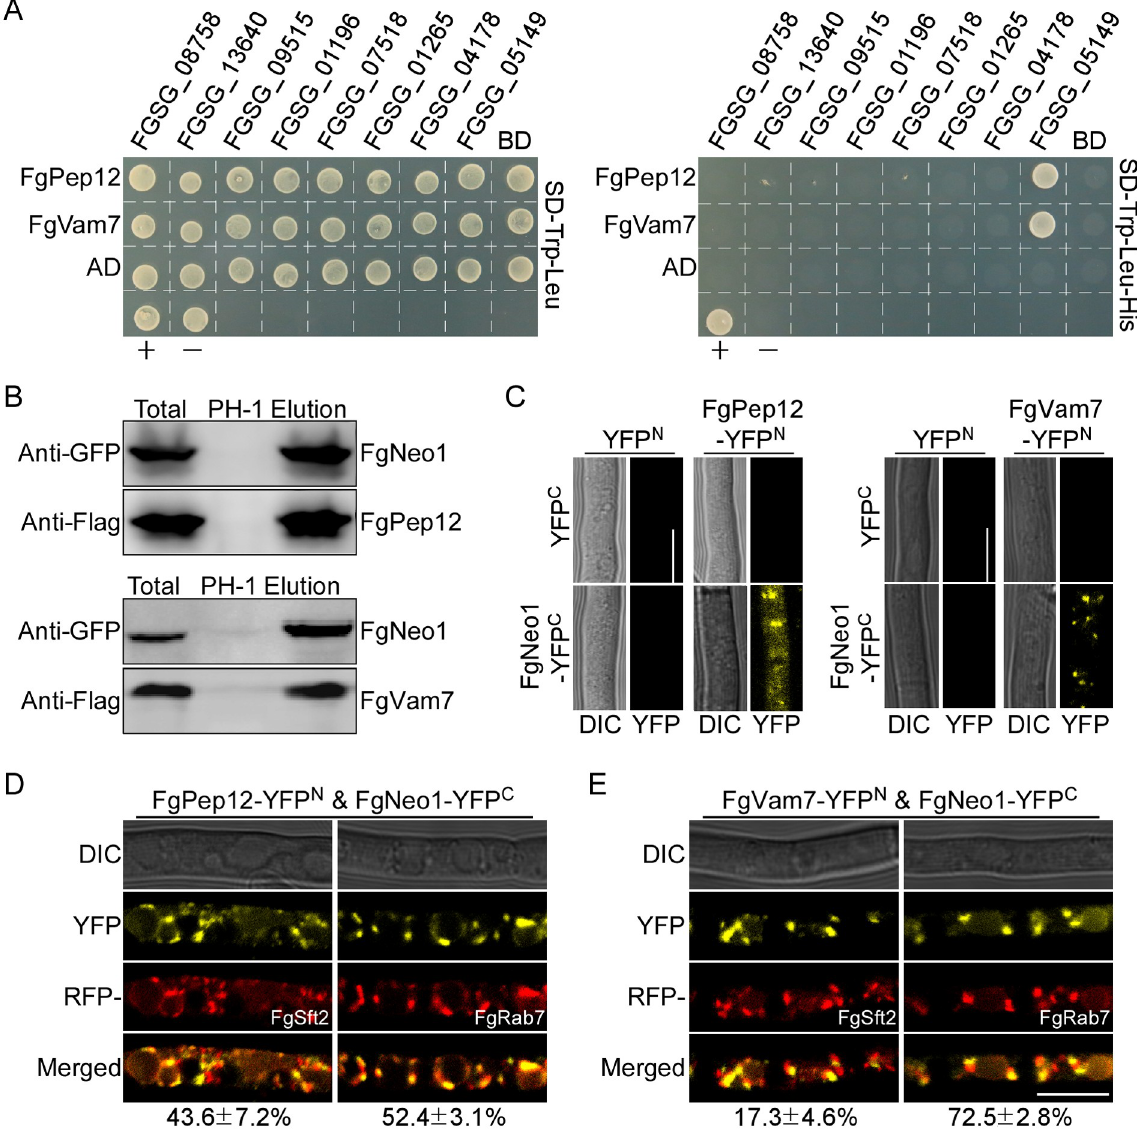
Fig 7. FgPep12 and FgVam7 physically interact with Ca 2+ ATPase FgNeo1 in F . graminearum . (A) Y2H assays for the interactions between FgPep12, FgVam7 and the predicted intracellular calcium signaling-related proteins, respectively. +, positive control; -, negative control. (B) Co- IP assays for the interactions between FgPep12 and FgNeo1, FgVam7 and FgNeo1. Total proteins were isolated from transformants co- expressing GFP-FgNeo1 and FgVam7-3 × FLAG or FgPep12-3 × FLAG constructs, and proteins eluted from the anti-FLAG M2 beads (elution). Immunoblots were incubated with monoclonal anti-FLAG and anti-GFP antibody, respectively. (C) BiFC assays for the interactions between FgPep12 and FgNeo1, FgVam7 and FgNeo1, respectively. (D and E) Hyphae of transformants expressing RFP-FgSft2 or RFP-FgRab7 constructs in the FgPep12&FgNeo1 and FgVam7&FgNeo1 BiFC strains, were examined under a confocal microscope. Numbers indicate the merged rate of YFP and RFP proteins. Bar = 10 μ